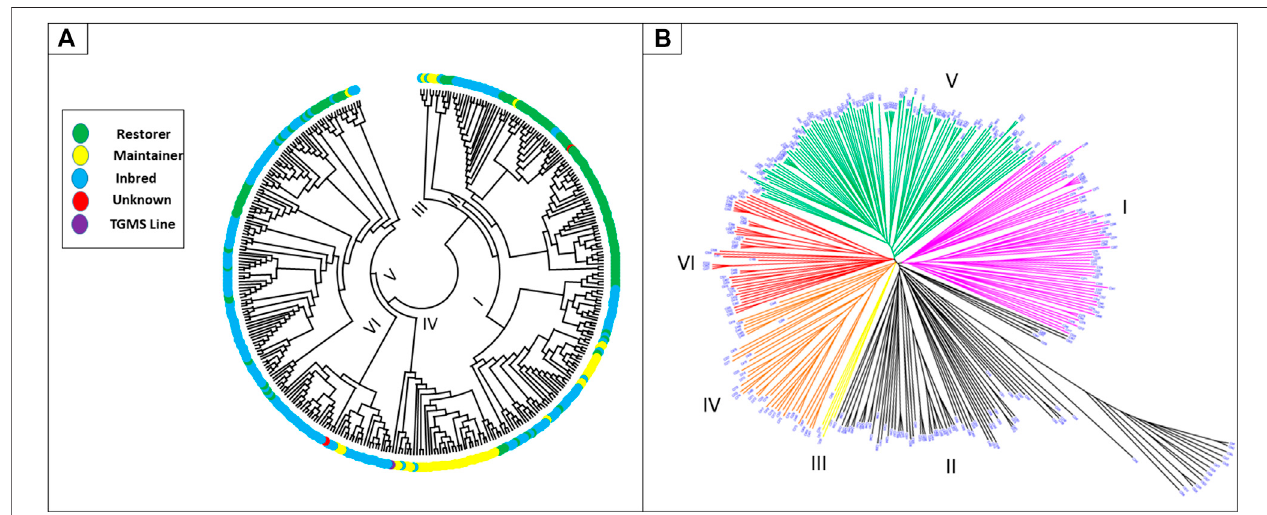
FIGURE 2 | Distribution of breeding lines (inbreds, maintainers, restorers, TGMS, and unknown) into different clusters (A) . Phylogenetic tree, showing the overall distribution of 359 rice accessions into six different clusters (B) .